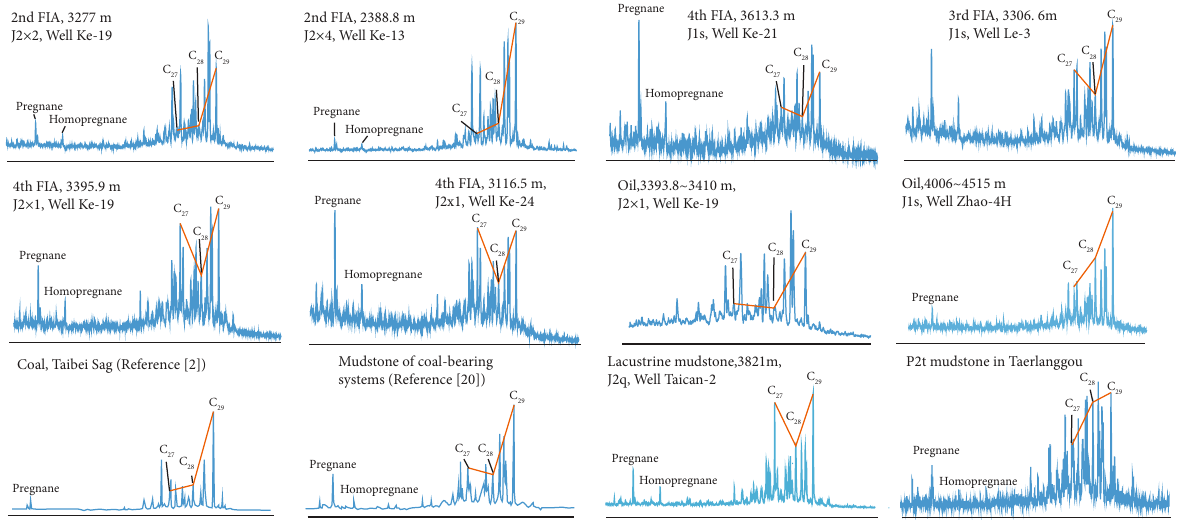
Figure 8: Sterane characteristics ( M / Z = 217 ) of inclusions, crude oil, and typical source rock of the Mid-Lower Jurassic in the northern piedmont belt of the Turpan-Hami